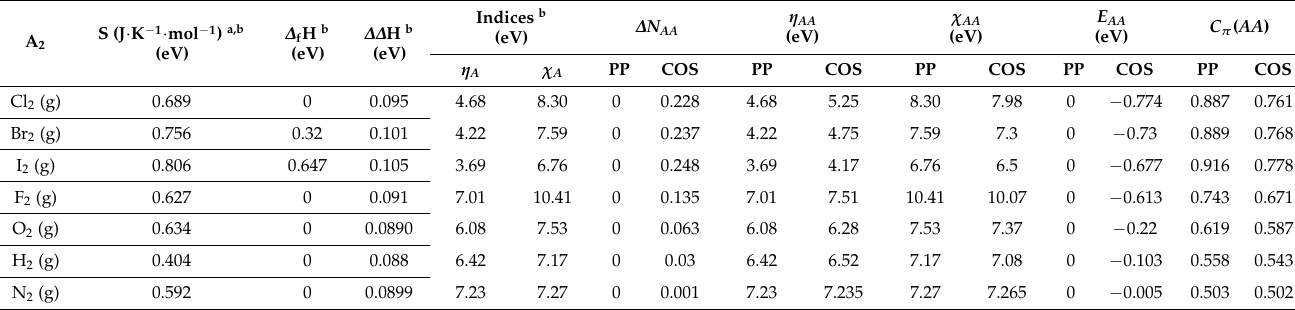
Table 4. The numerical comparison between sensitivity indices (charge transfer, average hardness, average electronegativity, exchanged energy, and the introduced chemical power) for Parr–Pearson (in table: PP) and present chemical orthogonal space (in table: COS) approaches for selected diatomic molecules formed by homo-atoms; enthalpy of formation ∆ H, the enthalpy difference ∆∆ H = H(298.15 K) − H(0) and the thermodynamic entropy were used as experimental counterpart. All energies are in eV (electron-volts).